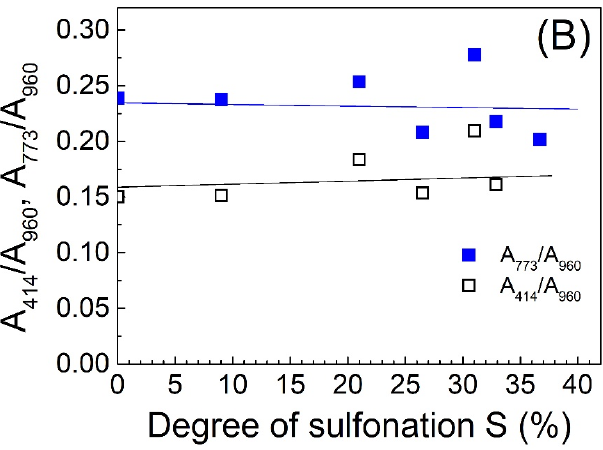
Figure 3. ( A ) FTIR spectra, in the wavenumber range 400–800 cm − 1 , of unsulfonated (curve (a)) and sulfonated (curves (b–d)) PPO aerogels obtained for a PPO:sulfonating agent ratio of 1:4 and different swelling times (indicated as t sweelling ) and heating reaction times (indicated as t heating ). ( B ) Variation of the normalized absorbance of the 773 and 414 cm − 1 bands as a function of the sulfonation degree.